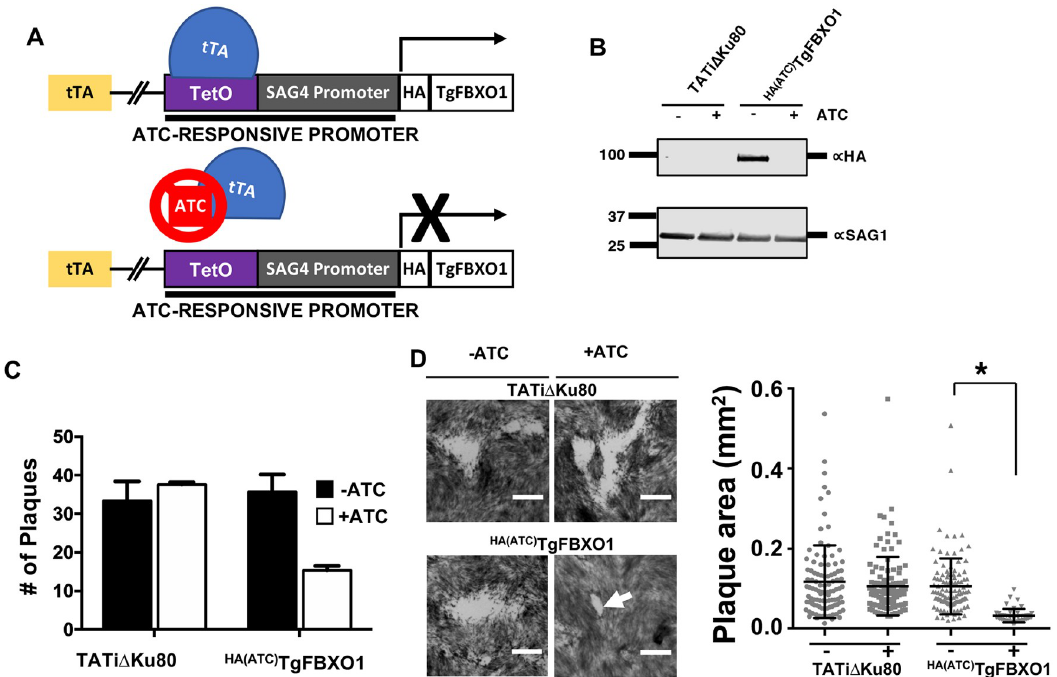
Fig 2. TgFBXO1 is important for Toxoplasma growth. (A) . Schematic illustration of HA(ATC) TgFBXO1 anhydrotetracycline (ATC)-regulated gene expression. The TgFBXO1 endogenous promoter was replaced with a SAG4 promoter containing a tetracycline transactivator (tTA) binding element. In the absence of ATC, the tetracycline regulated promoter is active, while the addition of ATC reduces transcription by preventing tTA from binding to and activating the promoter. (B) . Lysates from HA(ATC) TgFBXO1 or parental TATi Δ Ku80 parasites grown for 24 h in the absence or presence of 1 μ g/ml ATC were Western blotted to detect HA(ATC) TgFBXO1 or SAG1 as a loading control. (C) . HA(ATC) TgFBXO1 or TATi Δ Ku80 parasites (100/well of a 6 well plate) were grown for 5 d on HFF monolayers with or without 1 μ g/ml ATC. The cells were then fixed and numbers of plaques formed counted. Shown are the averages and standard deviations of 3 independent experiments performed in triplicate. (D) . Representative images of plaques from (C) showing decreased plaque size of TgFBXO1-depleted parasites. Plaque sizes were quantified and plotted on the adjacent graph. � , p < 0.001, One-Way ANOVA. Bars = 0.5mm.